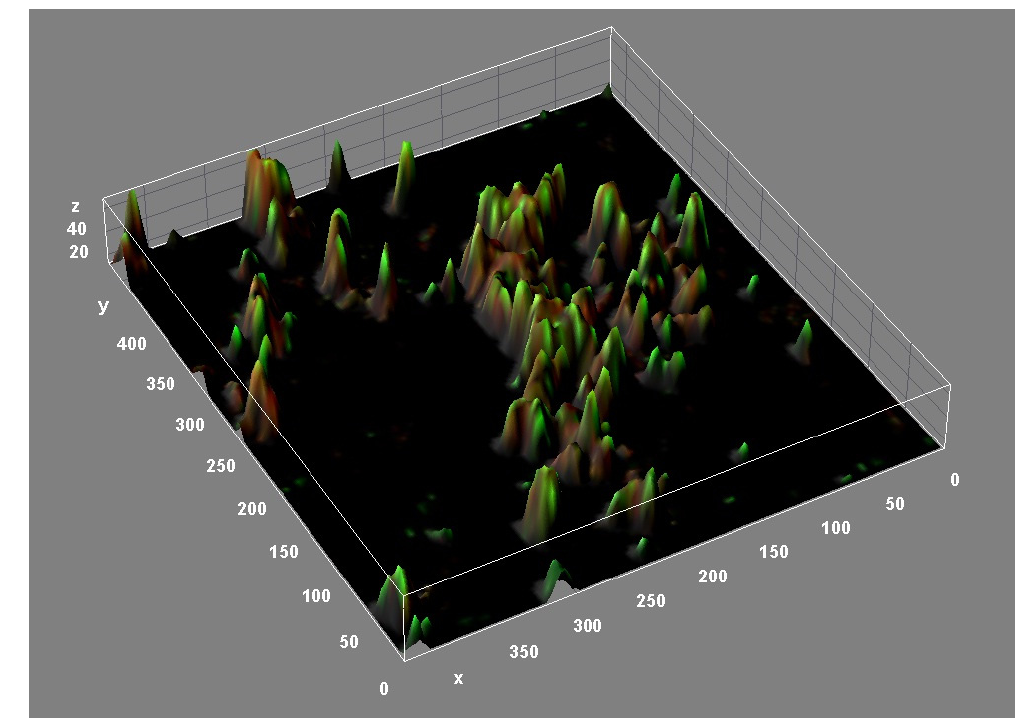
Figure 3. Three-dimensional reconstruction of an M. abscessus biofilm (CLSM, Backlight live-dead stain).